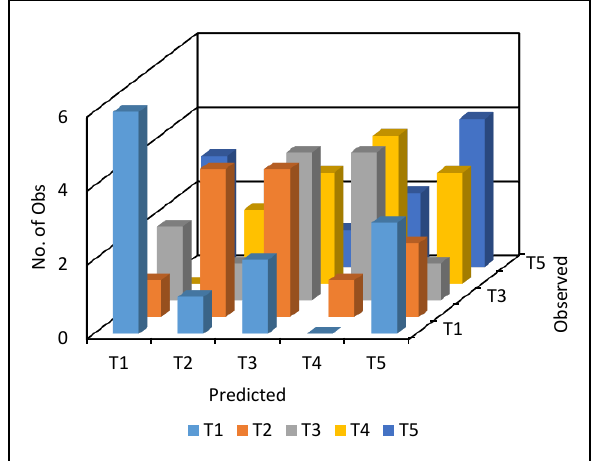
Figure 11. Classification Matrix for RF Model using Important